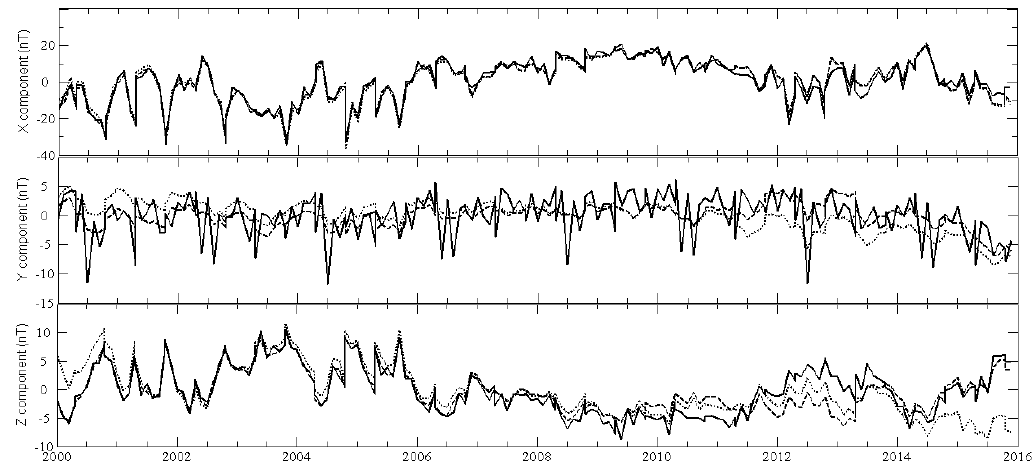
Figure 12. The external contribution to the KAK observatory, calculated as shown in the text for three models: POMME-9 (solid line), EMM2015 (dashed line) and CM5 (dotted